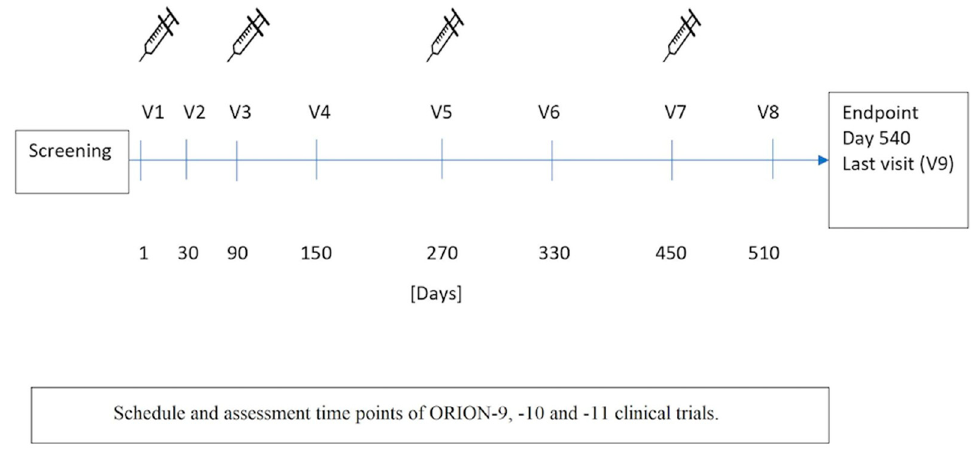
Figure 3. Dosing schedule and time points assessment in ORION-9, -10 and -11 clinical trials. The safety and efficacy of inclisiran were also assessed in patients with homozygous familial hypercholesterolemia (HoFH) in the ORION-5 study [95,96]. The disease, as a consequence of mutations in LDLR , APOB , or PCSK9 genes inherited from both parents, is characterized by extremely elevated LDL-C levels and, subsequently, high risk for premature cardiovascular diseases [97,98]. Participants who met the inclusion criteria were randomly assigned to receive either a dose of 300 milligrams of inclisiran or a placebo. An absolute change in LDL-C level from baseline up to day 180 in inclisiran group was ( − 14.5) mg/dL [( − 47.5) − 18.5] versus ( − 7.0) mg/dL [( − 50.5) − 36.4] in the placebo